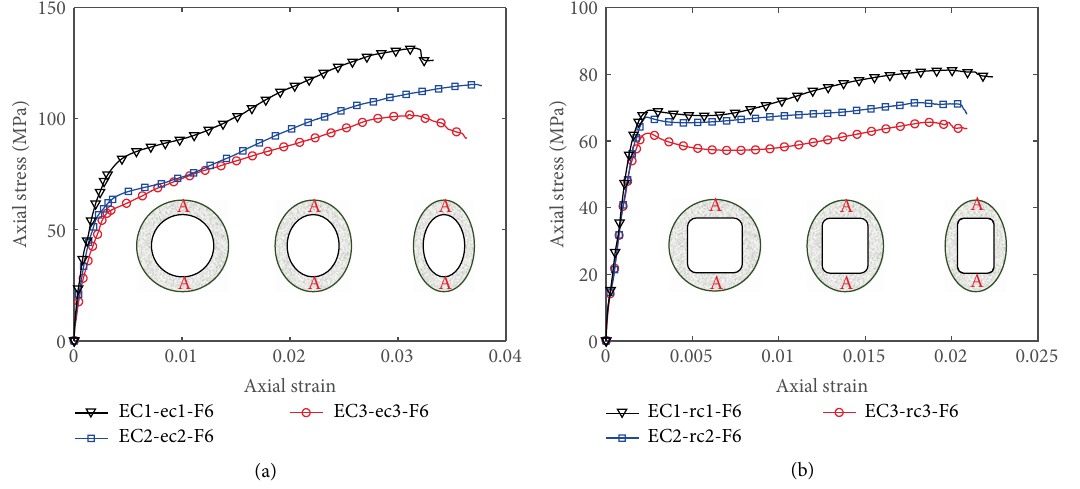
Figure 10: Effect of cross-sectional aspect ratio. (a) EE-DSTCs. (b)